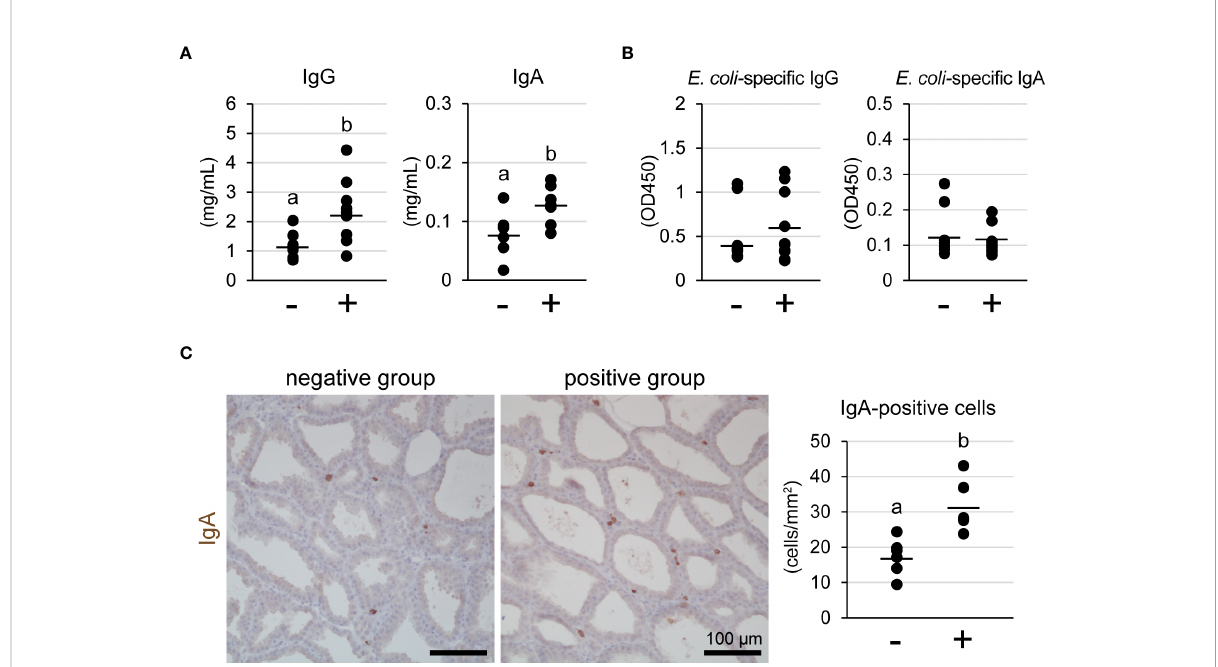
FIGURE 4 Concentrations of IgG and IgA (A) and titer against Escherichia coli -speci fi c IgG and IgA (B) in milk of tertiary lymphoid organ-positive and -negative goats. (C) Representative images of immunohistochemistry against IgA and number of IgA-positive cells. ( − ) lymphocyte aggregation- negative group; (+) lymphocyte aggregation-positive group. Scale bar, 100 m m. Different letters indicate a signi fi cant difference between groups (p <